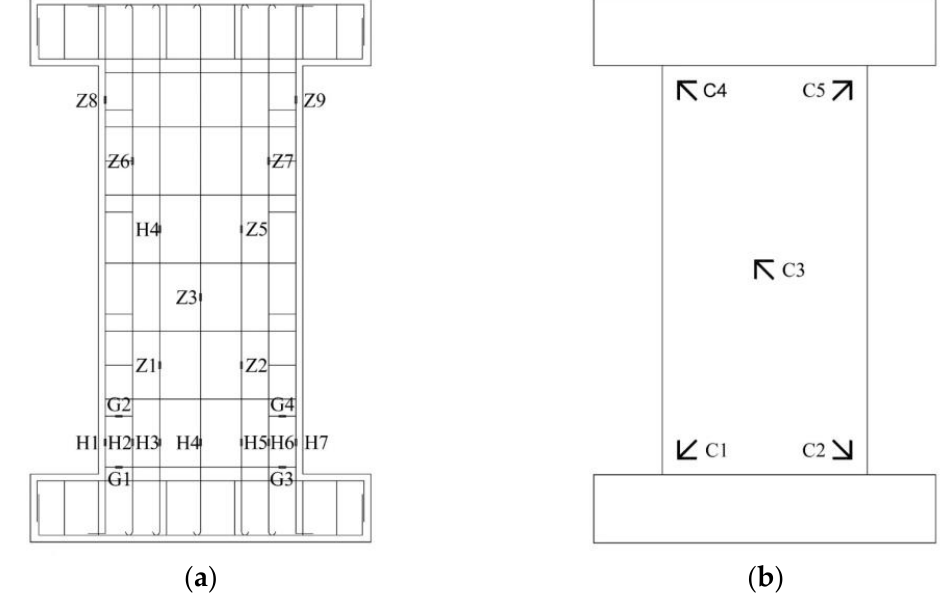
Figure 7. Strain gauge layout ( a ) Reinforcement strain gauges ( b ) Concrete strain gauges.